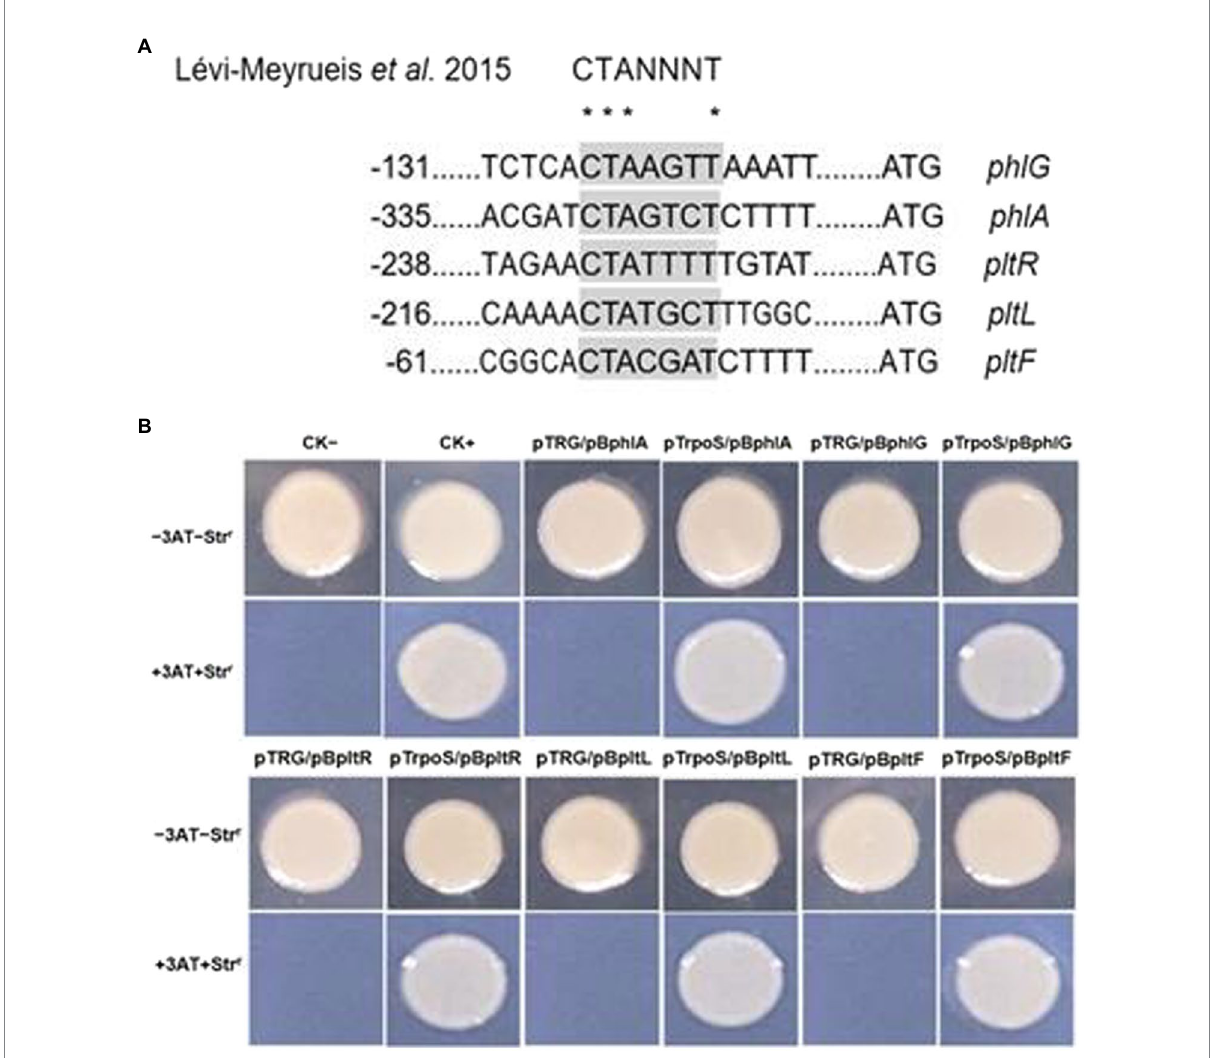
FIGURE 5 RpoS and its target DNA-binding specificity assay. (A) Identification of the RpoS-10 consensus motif in the promoter regions of antibiotic biosynthetic genes in P. protegens FD6. (B) Direct interactions between RpoS with the promoter regions of its targets in P. protegens FD6. The E. coli XL1-Blue MRF’ Kan carrying pTvfr and pBvfr plasmids were used as a positive control on a selective screening medium